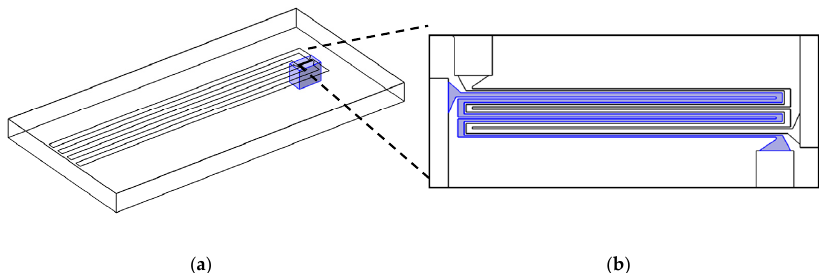
Figure 9. ( a ) Simulation model for the sensor structure on top of a thin-film membrane on a silicon substrate with a backside cavity. The thermal conductivity of the volume inside the cavity (blue) is λ Por . ( b ) Detailed view of the heater structures. The active heater is highlighted in blue.